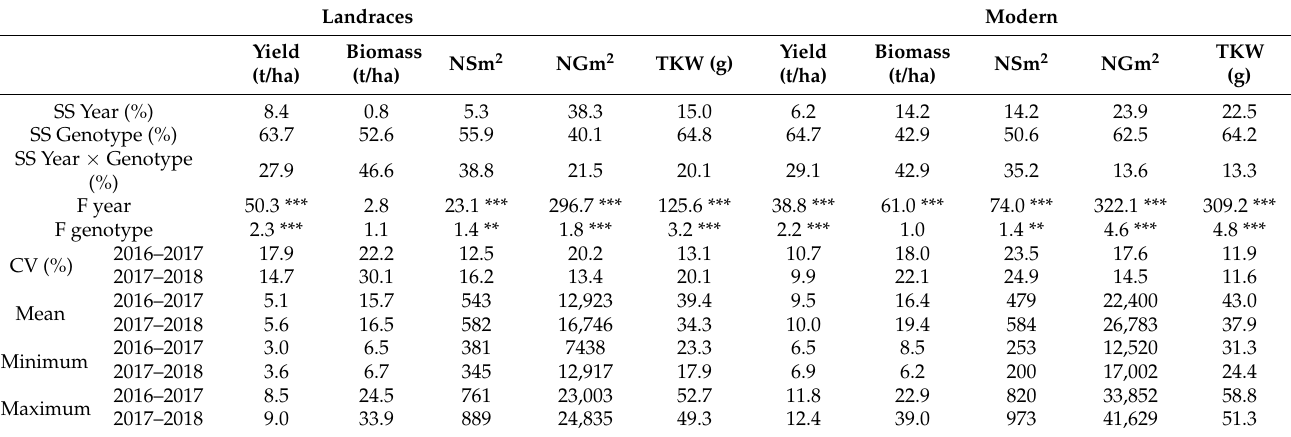
Table 5. Analysis of variance performed separately for 181 landraces and 184 modern cultivars and values for grain yield, biomass, number of spikes per square meter (NSm 2 ), number of grains per square meter (NGm 2 ), and thousand kernel weight (TKW) for each growing season. SS, sum of squares. CV, coefficient of variability. ** p < 0.01. *** p <